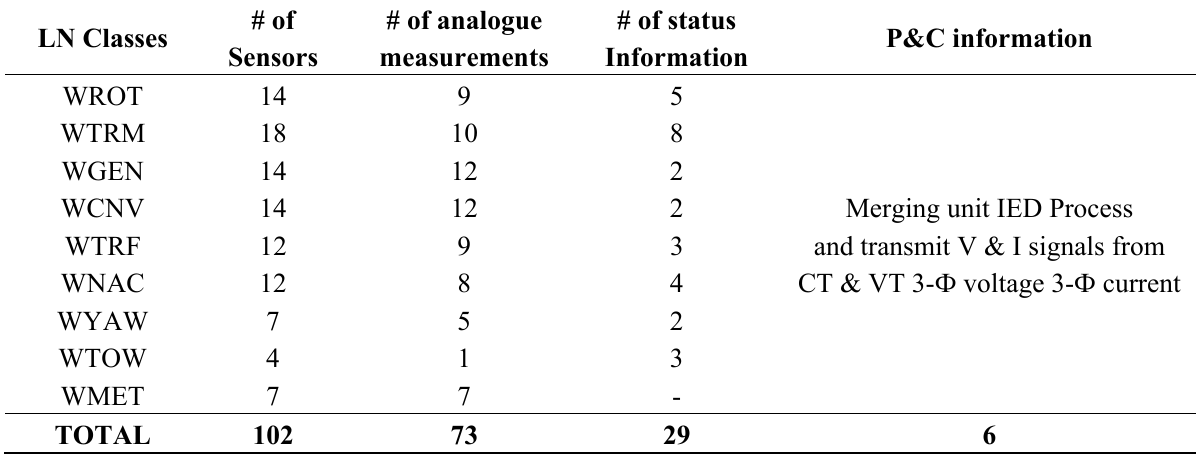
Table 5. Sensor nodes and measurement devices of a wind turbine.